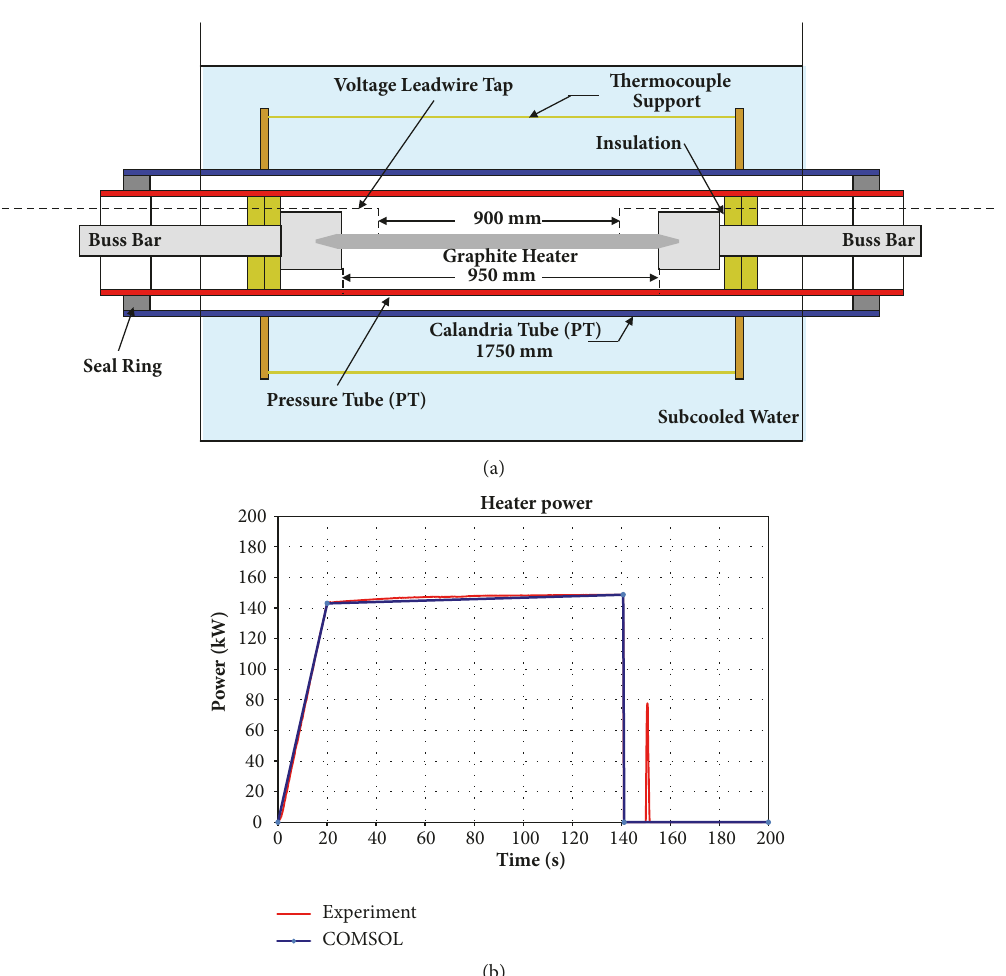
Figure 1: IAEA/ICSP benchmark for this simulation: (a) schematic drawing and (b) heater power versus time.